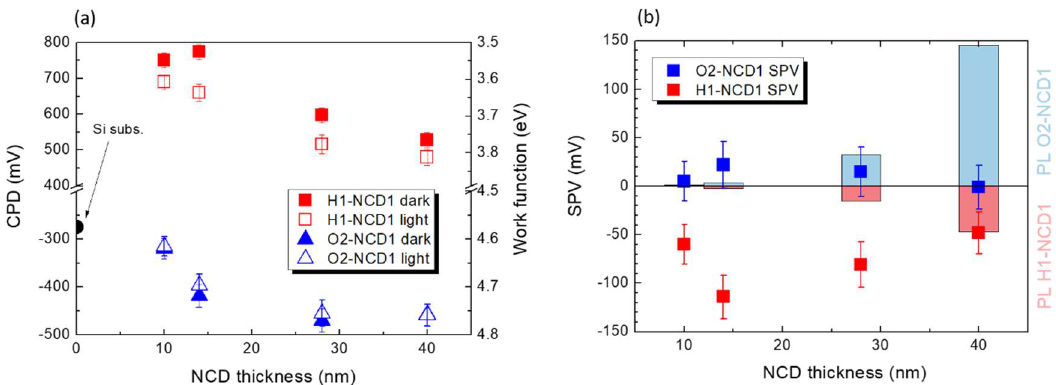
Figure 3. Contact potential difference (CPD) dependence on NCD1 thickness, surface chemistry, and illumination ( a ). Surface photovoltage (SPV) dependence on NCD thickness and surface chemistry. SiV PL intensity is shown as red (H1-NCD1) and blue (O2-NCD2) bars ( b